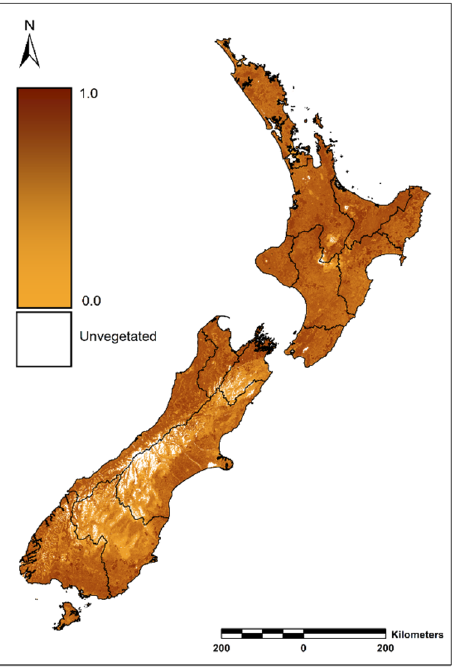
Figure 6. A national map of median NDVI, omitting dates for each pixel where the NDVI is negative. Regional boundaries are shown in black.